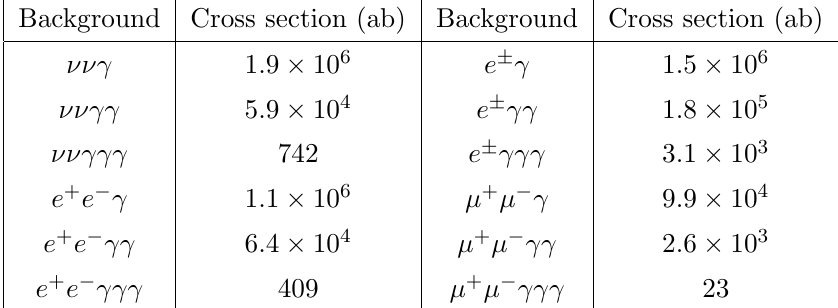
> 25 GeV, j cos (cid:18) (cid:13) j < 0 : 99, and a veto T